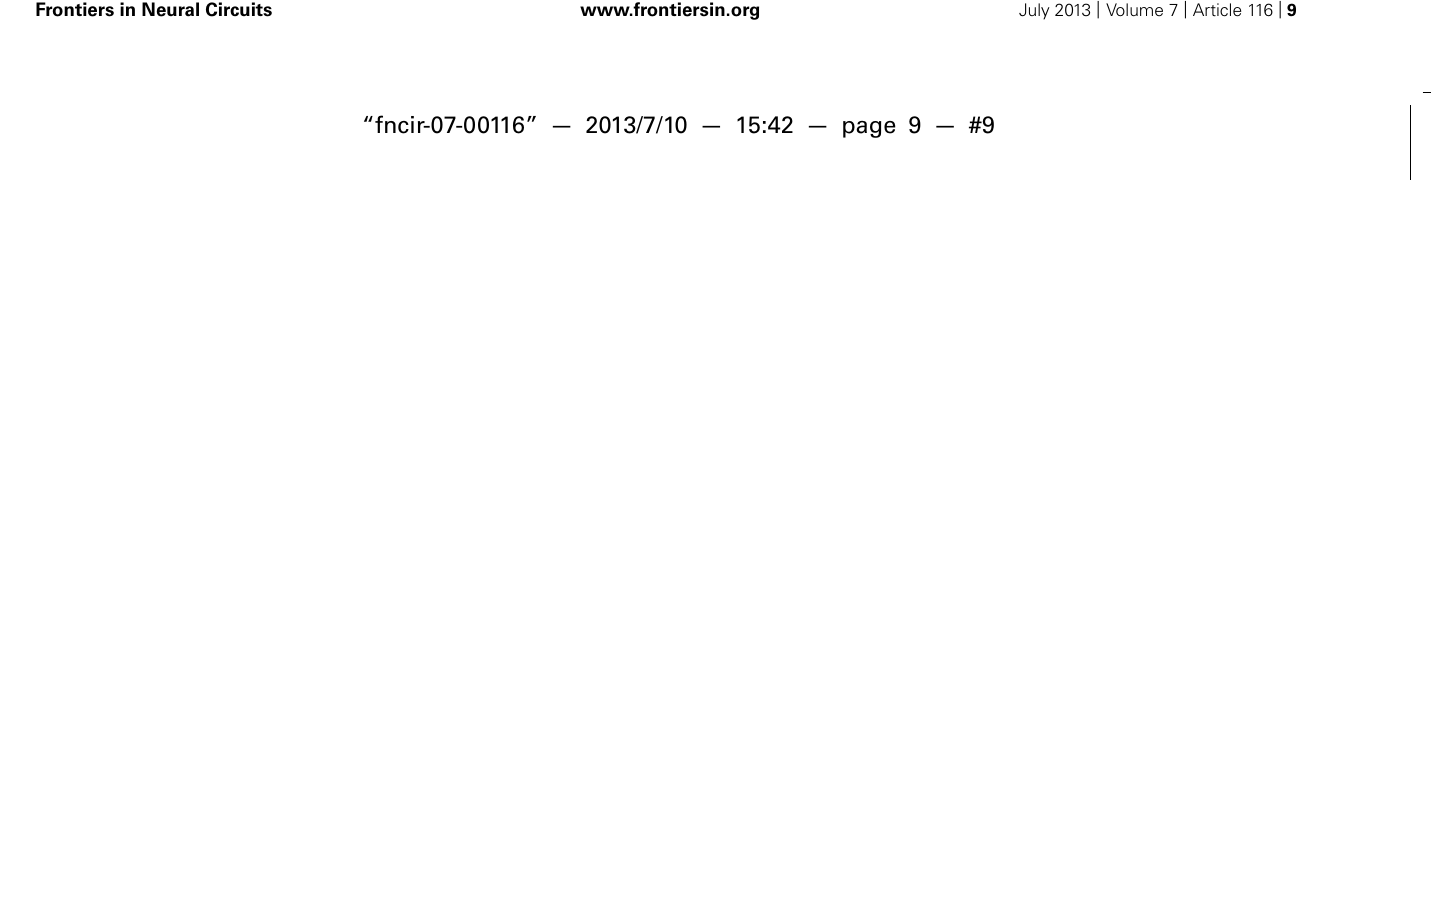
from a neuron after gabazine administration. Note the increase in number of PDSs with depolarization. (D–F) Magnifications of PDSs from the corres- ponding traces in (A–C) . Note that the PDSs’ waveform is